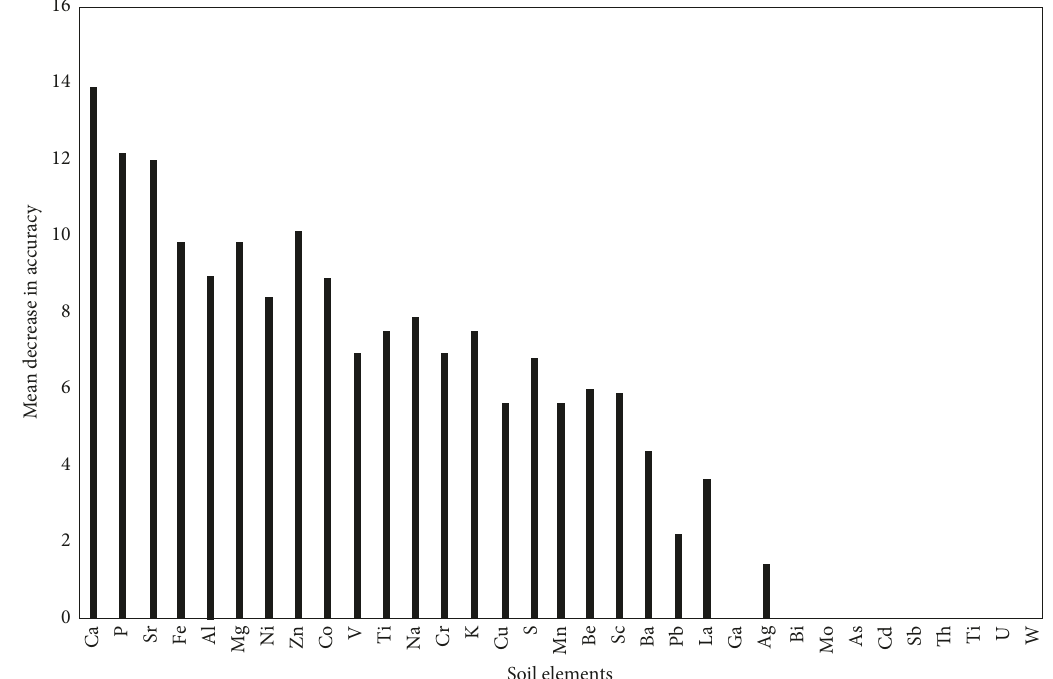
Figure 4: Variable importance computed by the RF algorithm. The highest MDA indicates the most important elements.